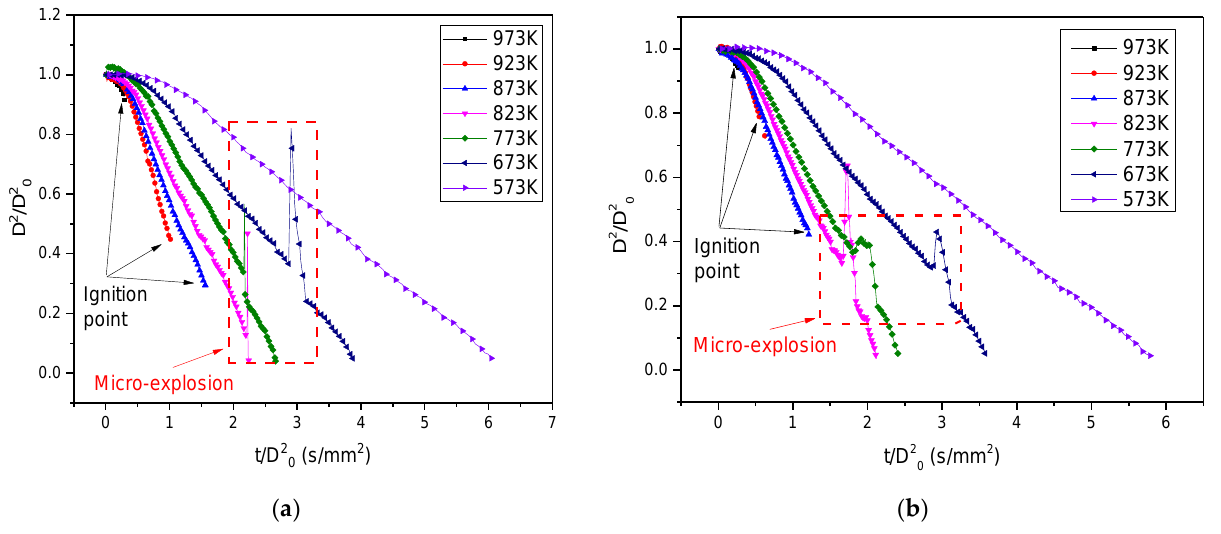
Figure 9. Influence of temperature on micro-explosion at ( a ) 0.6 bar and ( b ) 0.8 bar.